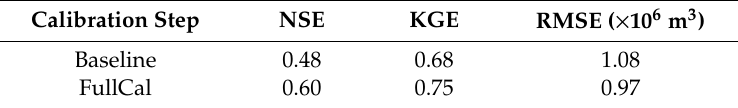
Figure 5. Amplified windows of March to May 2005–2009, in which temperature starts to rise across the freezing point, showing incapability of the DHSVM in simulating peak streamflow produced by combinations of thawing active layer of frozen ground, snowmelt and glacier melt.